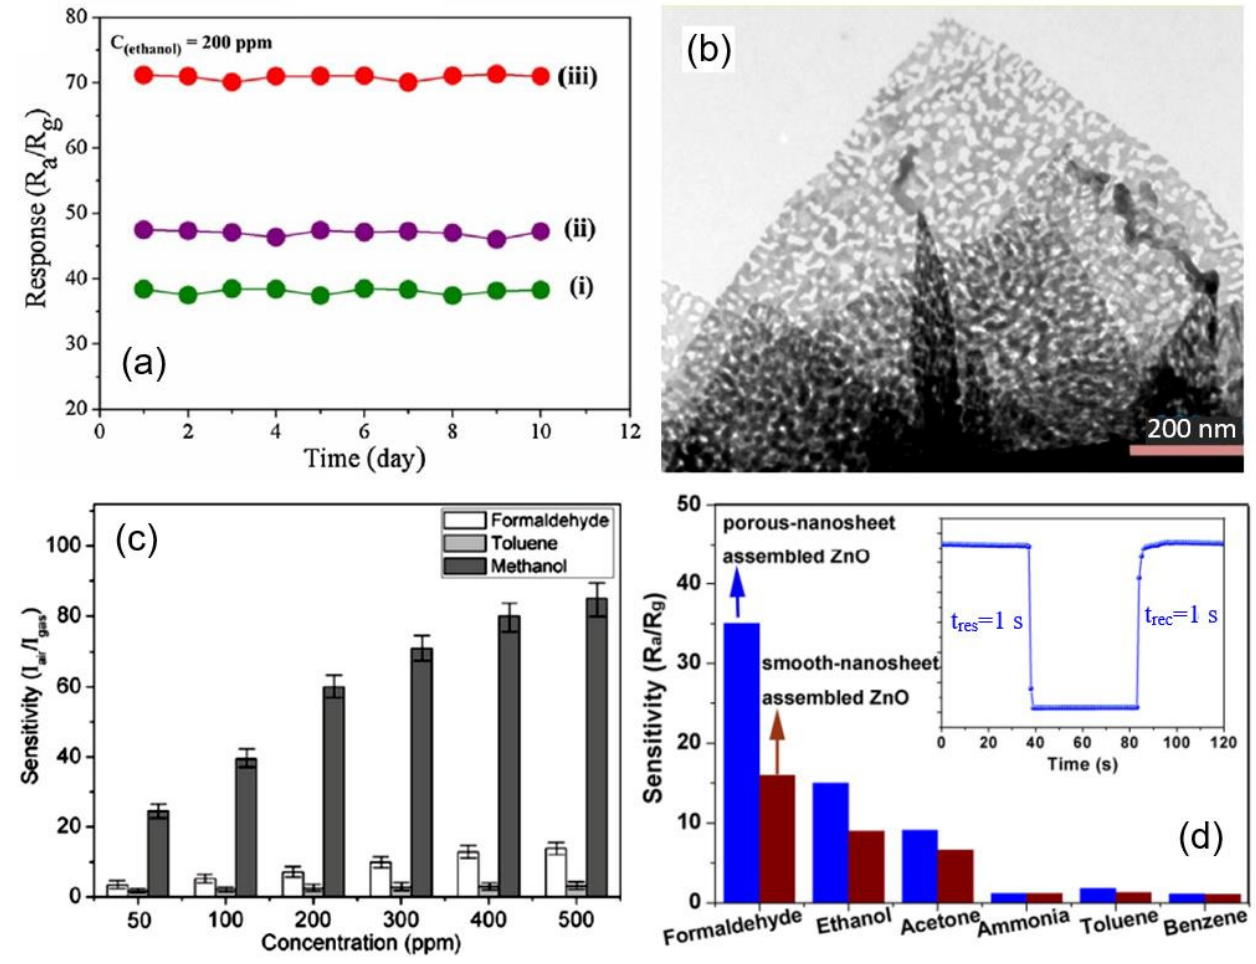
Figure 20. ( a ) Repeatability test of the (i) blooming, (ii) semi-blooming, and (iii) mesoporous semi- blooming SnO 2 nanoflowers-based sensors towards 200 ppm ethanol at optimal operating tem- perature. ( b ) TEM images of mesoporous semi-blooming SnO 2 nanoflowers with an average pore size of 31 nm. Reprinted with permission from Li et al. [85]. Copyright 2016: Elsevier; ( c ) Sensor responses of the gas sensor based on porous In 2 O 3 nanoflowers toward formaldehyde, toluene, and methanol. Reprinted with permission from Liu et al. [150]. Copyright 2010: ACS; ( d ) responses of porous ‐ nanosheet assembled ZnO and smooth ‐ nanosheet ‐ assembled ZnO ‐ based sensors to 100 ppm different testing gases at 260 °C. The inset is the response transient of porous ‐ nanosheet ‐ as ‐